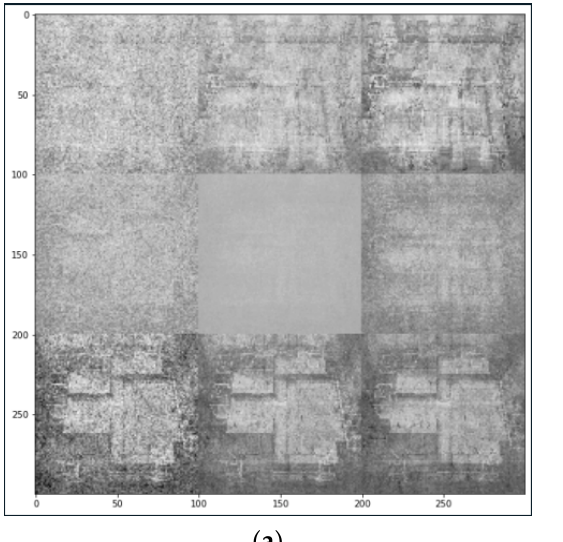
Figure 7. The zoom-in version of an output game map of Arknights after the mixing of several processed images in the VAE model. As observed from Figure 6, the images generated by the VAE model could retain the characteristics and features of the original image, and a new image could be e ff ectively generated by mixing several original raw images from [42]. The mixing process was feasible (as shown on Figure 6(b)). However, when zooming in the output and a tt empting to visualize the fi ne details of an image, it was noticed that the sharpness of the output image was rather insu ffi cient, mainly due to the noise components induced during the training process. It is suggested to apply a suitable Laplacian sharpening fi lter or Sobel gradient for spatial enhancement, so that the edges of fi gures within the image can become more obvious [57]. Nevertheless, the new output images from the VAE model can still serve as good references for game designers when creating new game levels, or when adding in new characters and spatial features into particular video frames. After obtaining the output images, numerical experiments were conducted using the same dataset for exploring the statistical properties of the VAE model. First, Figure 8 shows one of the most well-known learning curves, with the aim of illustrating the